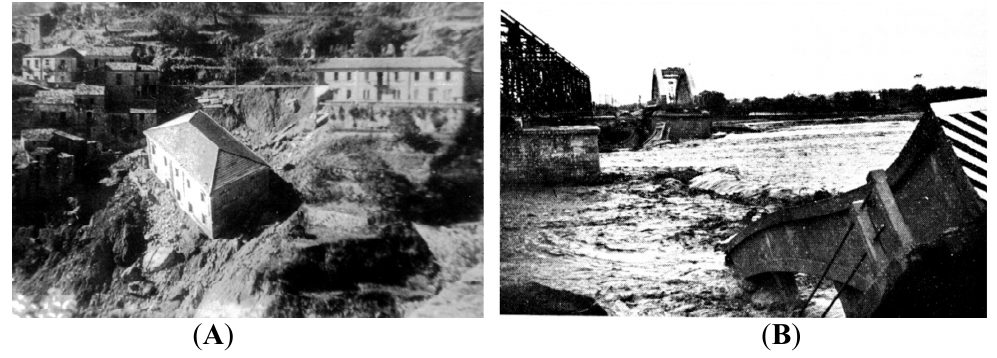
Figure 4. Damage caused by the analyzed DHE. ( A ) The city-hall of Grotteria village (Reggio C.), moved from the top of a hill because of a landslide (photo from the newspaper L’Unità ); ( B ) The broken bridge on the Careri river, in Reggio Calabria province (after Gulli,